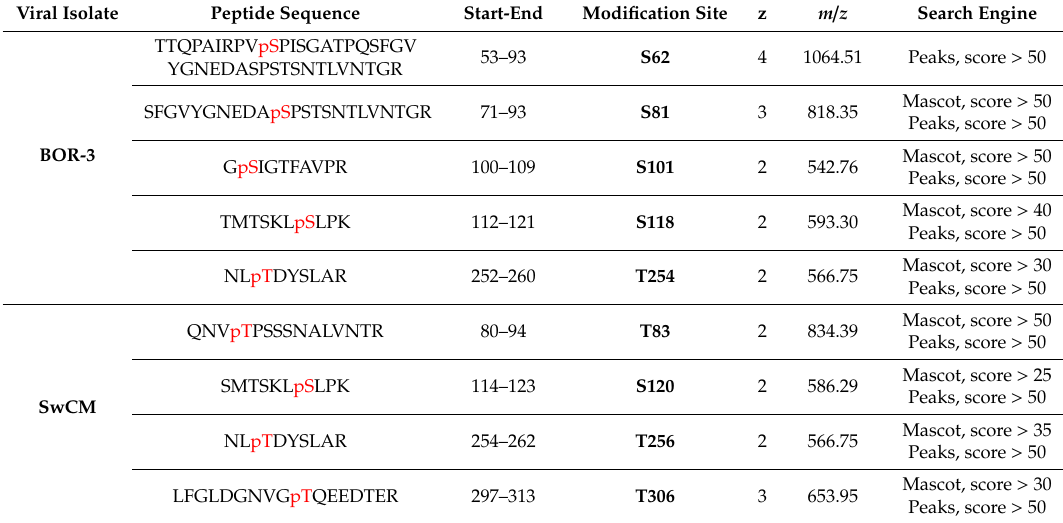
Table 1. Phosphorylation mapping in the coat protein (CP) of isolates BOR-3 and SwCM, after processing virions of Plum pox virus by LC-MS / MS.